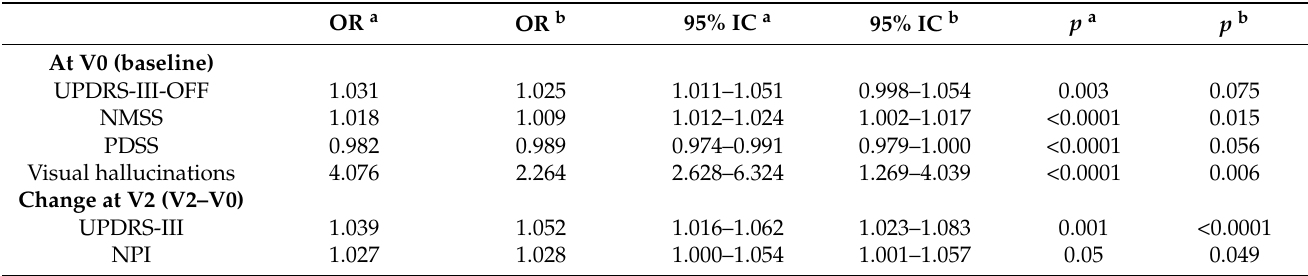
Table 3. Binary regression model about factors associated with